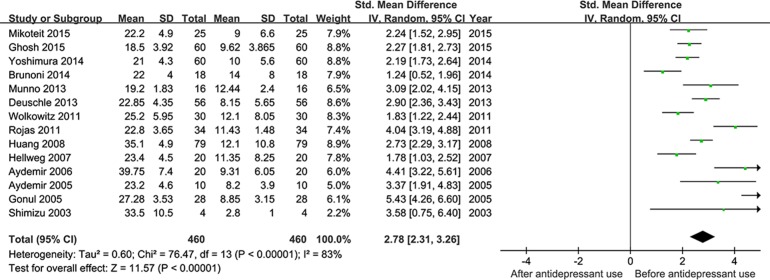
Meta-Analyses for the improvement of depressive symptoms after ADs (less than 12 week).